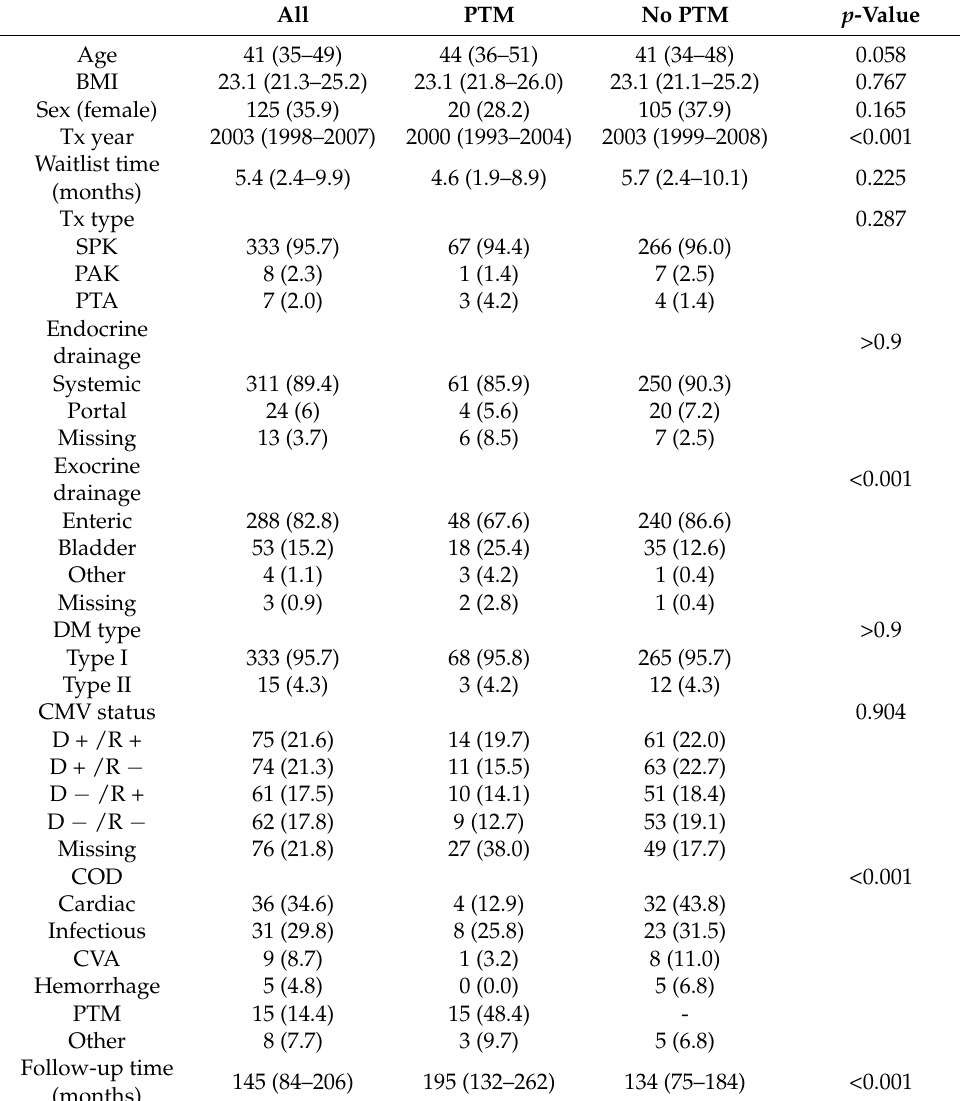
Table 3. Recipient